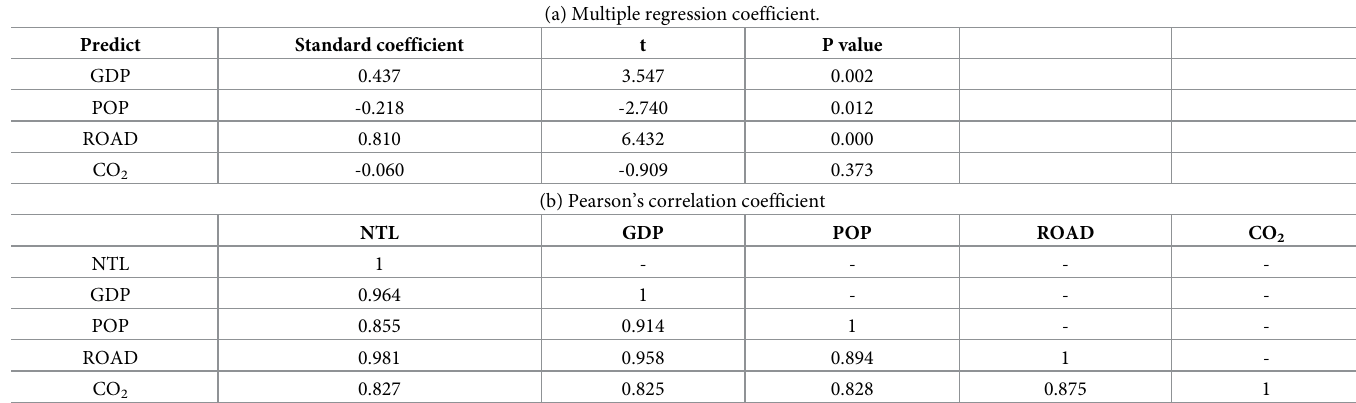
Table 5. Multiple regression coefficient and Pearson’s correlation coefficient of NTL density at provincial level in China after excluding three megacities. (a) Multiple regression coefficient.